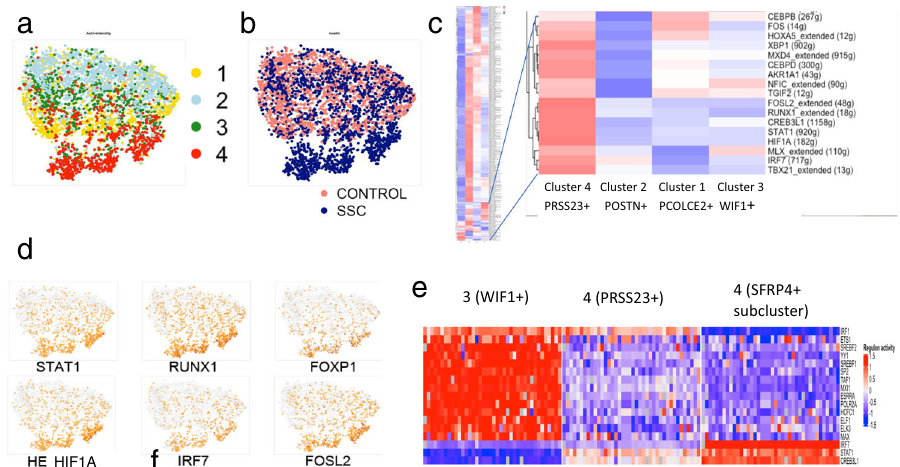
Fig. 8 Regulons associated with TFs. Clustering of fi broblast subclusters 1 – 4 by regulon expression, colored according to gene expression subclusters as in Fig. 2 and indicated in the legend ( a ) and according to SSc/healthy disease status ( b ). Clustering of regulons identi fi ed comparing fi broblast subclusters 1 – 4, expanded section showing regulons upregulated in cluster 4 ( c ). Gene expression indicated on regulon T -SNE plots of select TFs ( d , brown = increased expression. Iterative downsampling of regulons associated with clusters 3, 4, and cluster 4 ( SFRP4 + subcluster, i.e., myo fi broblasts), showing upregulated IRF7 , STAT1 , and CREB3L1 regulons ( e ). For clustering panels, red = high, blue = low